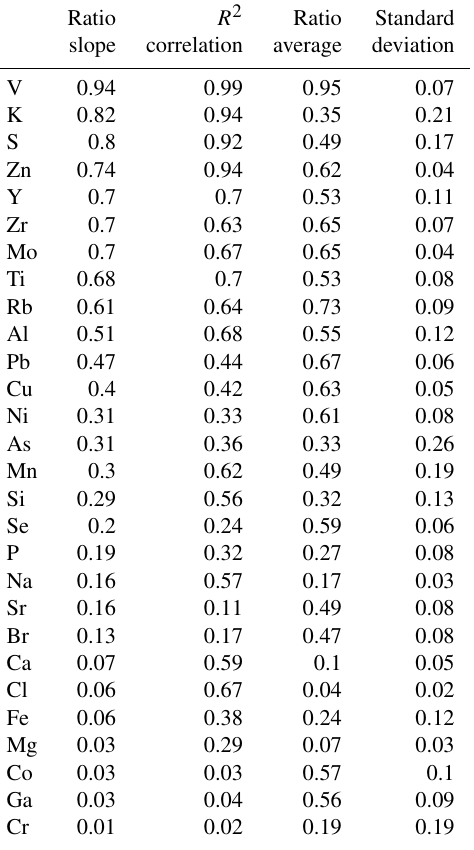
Table 1. PM 1 . 15 / PM 10 ratio slopes for elements ordered by ratio